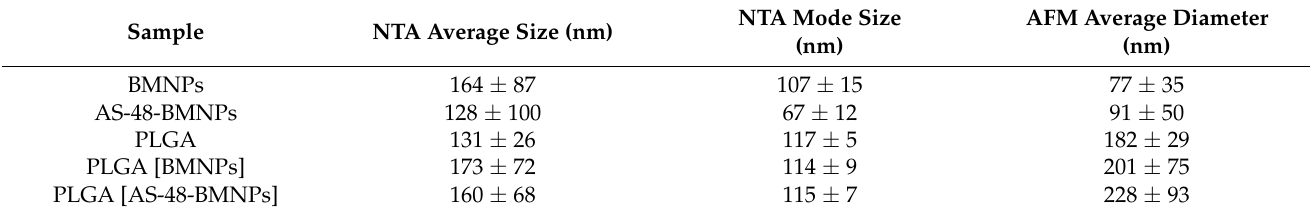
Table 2. NTA data compared to the AFM diameter. NTA average size represents the average ob- tained from three independent measures while the NTA mode size is the value most frequently detected. The values correspond to three independent experiments for which standard deviations were calculated.